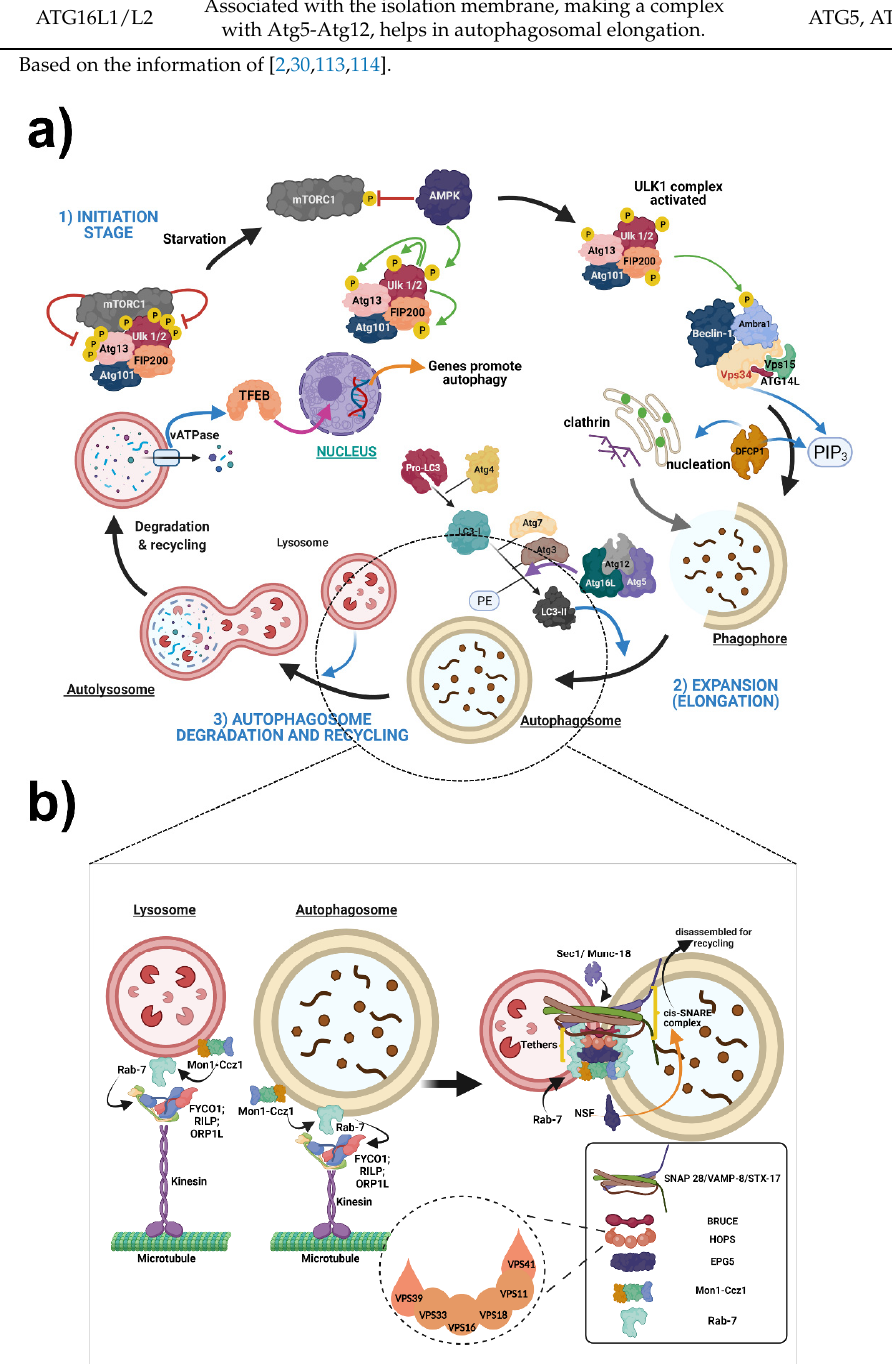
Figure 2. ( a ) Autophagy stage modulators. (1) Initiation stage: mTORC1 directly phosphorylates and inhibits the ULK-Atg13-FIP200 complex in nutrient-rich conditions. Phosphorylation of ULK1 and ATG13 prevents the induction of autophagy. Upon starvation, mTORC1 is inhibited and phos- phorylated by AMPK, which results in ULK1 activation. Subsequently, the ULK1 complex phos- phorylates the Ambra1 protein, which allows the recruitment of the Beclin-1-Vps34 complex (Be- clin1-Vps34-Vps15-ATG14L). Vps34 produces phosphatidylinositol-3-phosphate (PIP3) and re- cruits DFCP1 to promote nucleation. Via endocytosis mediated by Clathrin generates the phago- phore. (2) Expansion (Elongation): pro-LC3 is cleavaged by ATG4B and generates LC3-I. Then, ATG7 and ATG3 process LC3-I to be conjugated to PE and the ATG12-ATG5-ATG16L system to